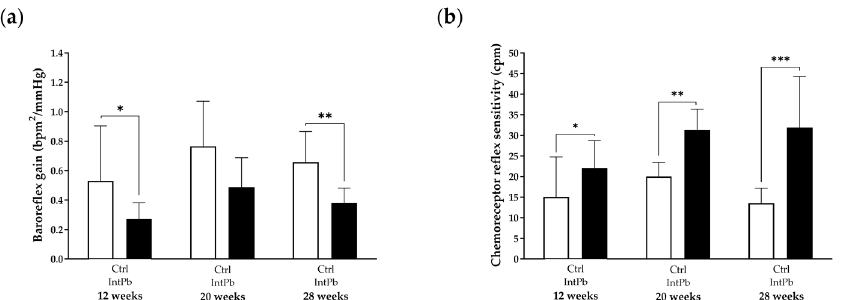
Figure 4. Variation of baro ‐ and chemoreflex expression along the three time points for all groups. ( a ) Baroreflex gain calculated from the variation in heart rate and blood pressure after phe ‐ nylephrine stimulation. ( b ) Chemoreceptor reflex sensitivity calculated from the variation in respir ‐ atory rate upon lobeline stimulation. Values are expressed as the mean ± SD for n IntPb = 12 and n Ctrl = 12 for each evaluated time ‐ point. The symbols denote statistically significant differences inter groups (Ctrl vs. IntPb—* p < 0.05; ** p < 0.01; *** p < 0.001); two ‐ way ANOVA, Tuckey’s multiple comparison test.